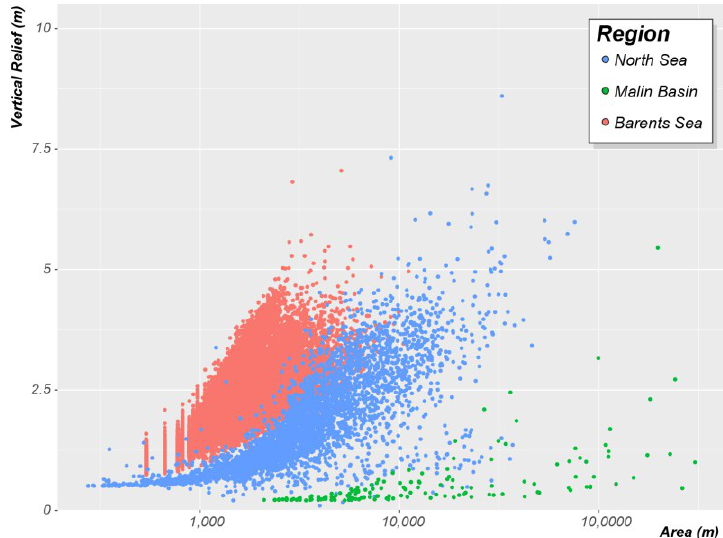
Figure 22. Vertical Relief as a function of Area comparing pockmarks mapped in the three studied regions (Barents Sea: red dots, North Sea: blue dots; and Malin Basin; green dots). Note that the five outlier values from the Witch Ground Basin are not presented here to facilitate better display of the general trends in the remaining data.